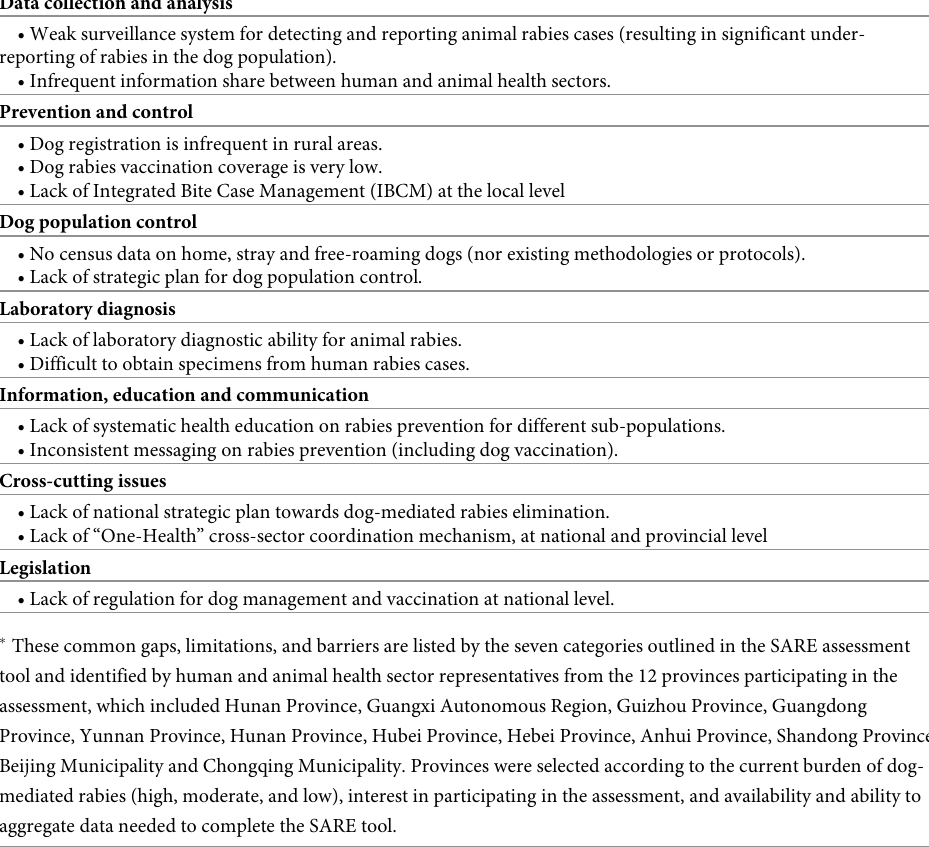
Table 2. Common gaps, limitations, and barriers at provincial level � identified from the Stepwise Approach towards Rabies Elimination (SARE) assessment, China, March 2019. Data collection and